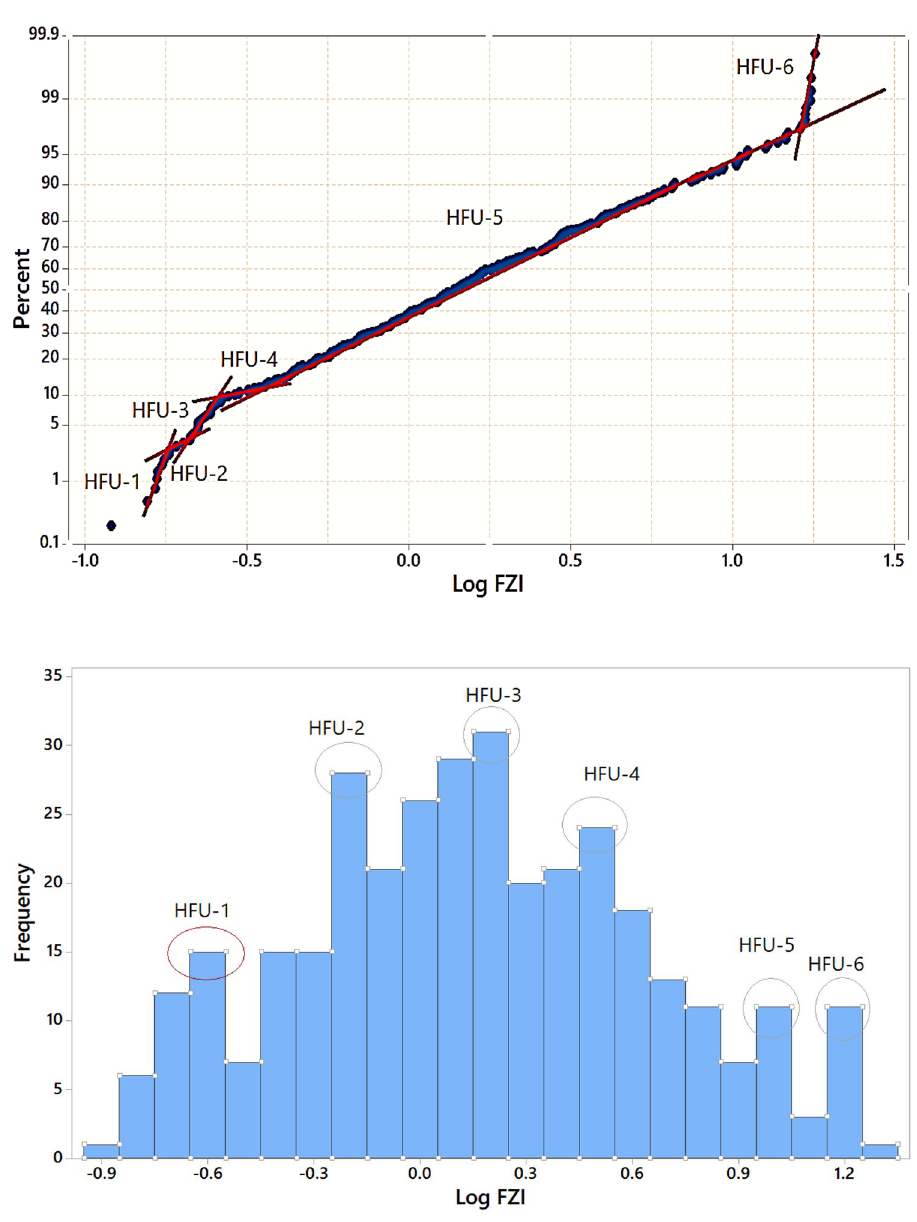
Fig. 12 Six distinct straight lines can be identified in the normal probability plot of log FZI, which shows six HFUs exist in this field